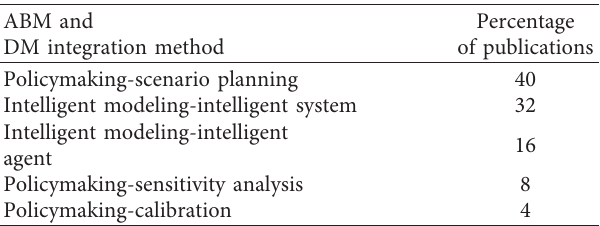
Table 2: Percentage of publications in each part of the